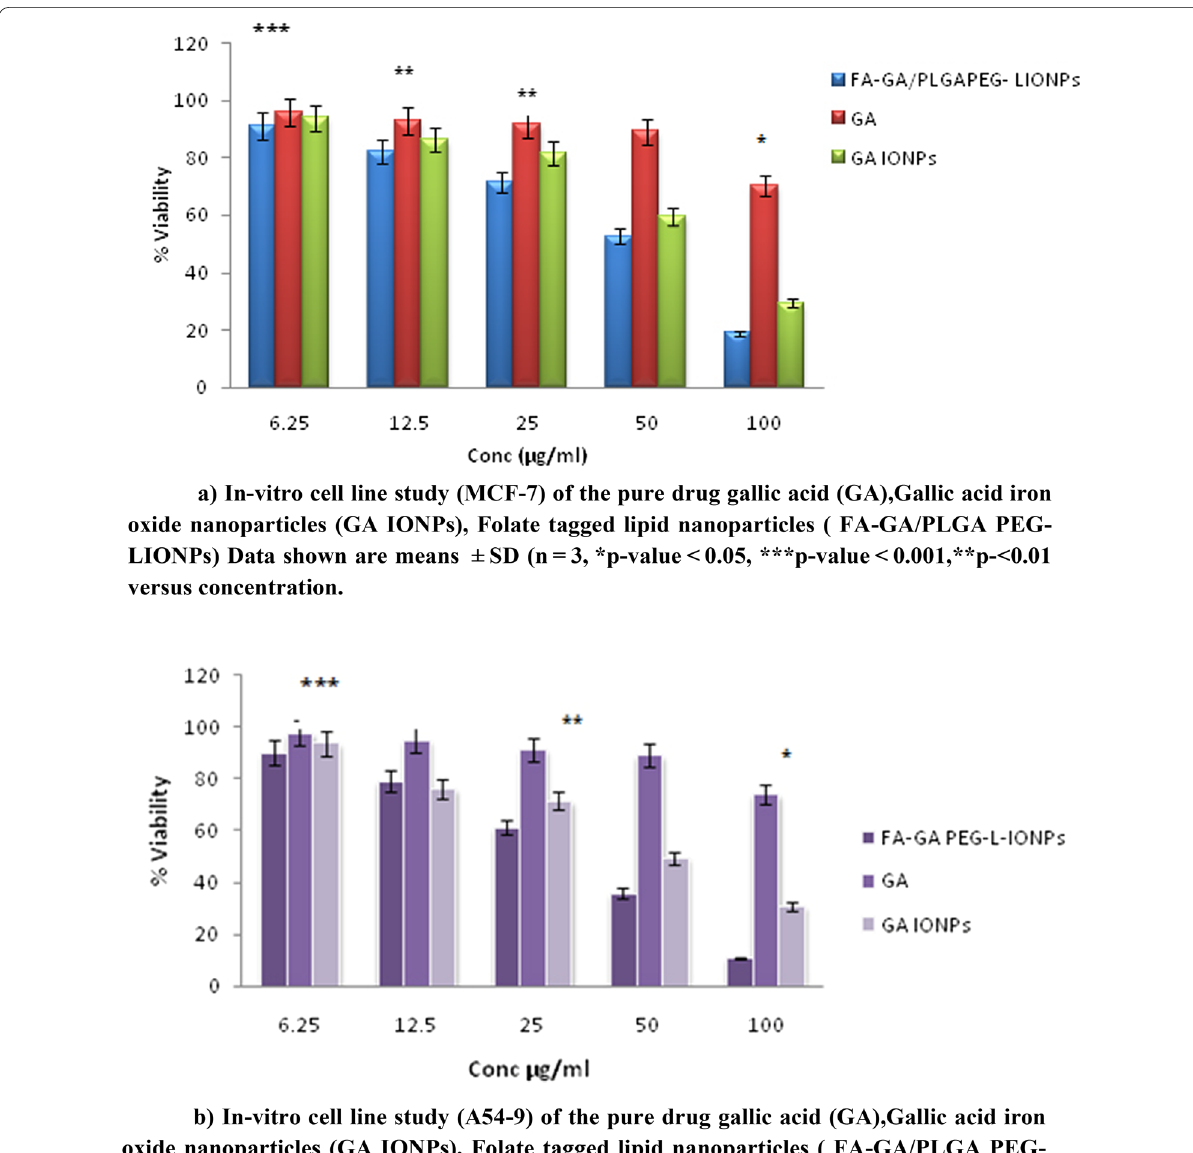
Fig. 10 a In vitro cell line study (MCF-7) of the pure drug gallic acid (GA), gallic acid iron oxide nanoparticles (GA IONPs), folate-tagged lipid nanoparticles (FA-GA/PLGA PEG-LIONPs). Data shown are means In vitro cell line study (A54-9) of the pure drug gallic acid (GA), gallic acid iron oxide nanoparticles (GA IONPs), folate-tagged lipid nanoparticles ( FA-GA/PLGA PEG-LIONPs). Data shown are represented as means